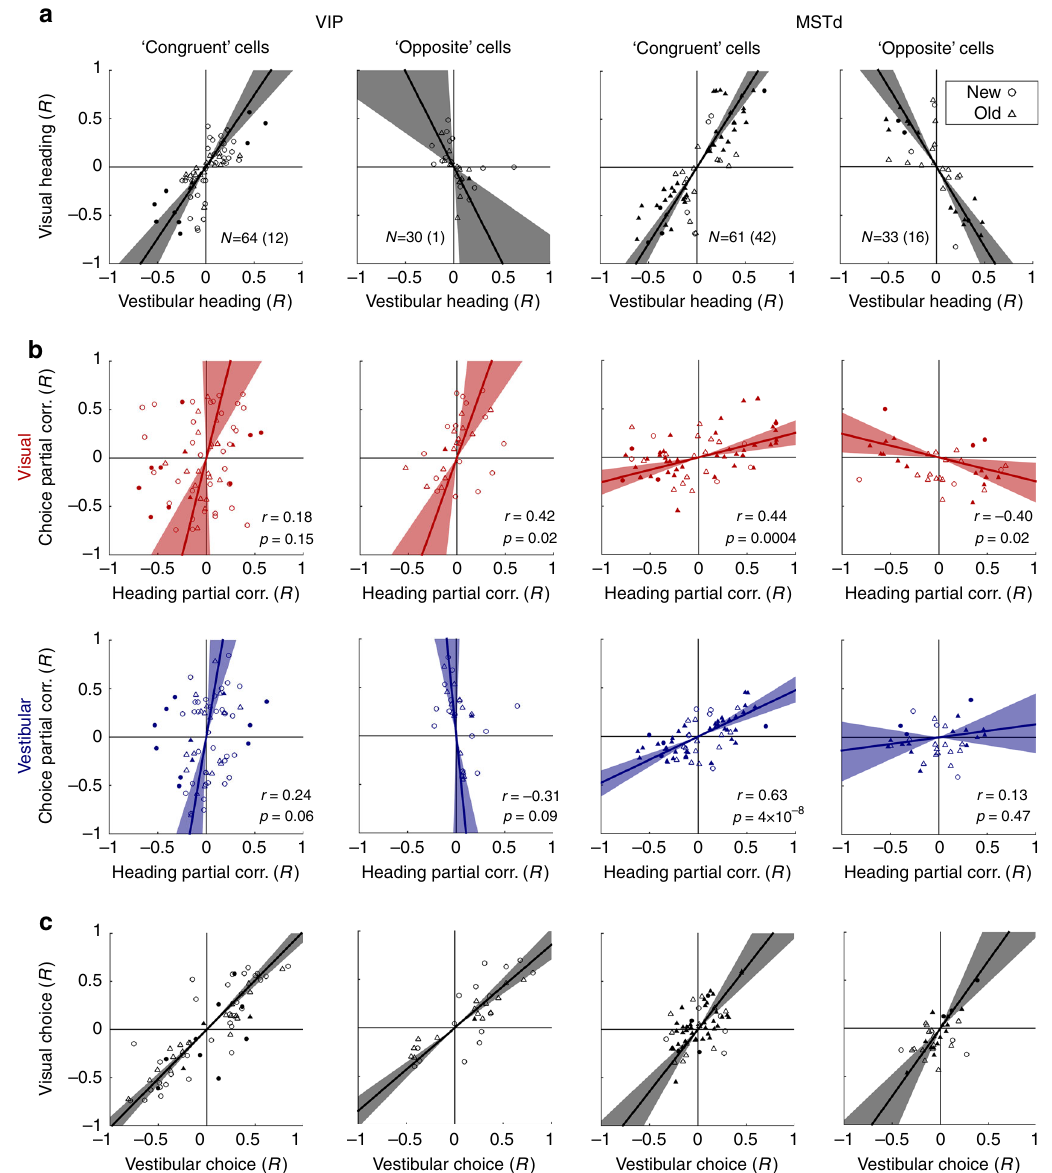
Fig. 5 Partial correlation results for congruent and opposite cells. a Visual and vestibular heading partial correlations are presented for neurons classi fi ed as ‘ congruent ’ or ‘ opposite ’ based on whether the visual and vestibular partial correlations for heading had the same or opposite signs, respectively. Signi fi cantly congruent or opposite cells ( p < 0.05 for both the visual and vestibular heading partial correlations) are marked by fi lled data points. Circle and triangle symbols mark the new and the old data sets, respectively. N values represent the number of cells (the number of signi fi cantly congruent or opposite cells in parentheses). Only cells which showed a signi fi cant main effect of heading or choice ( p < 0.05, two-way ANOVA) for both visual and vestibular conditions were included. b Heading and choice partial correlations are presented for the same cells. Red and blue symbols represent the data for the visual and vestibular conditions, respectively. c Choice partial correlations measured during the visual and vestibular conditions are compared for the same cells. Solid lines and the shaded regions represent type-II regressions with their 95% con fi dence intervals. r and p -values for the regressions in panel b are presented on the respective plots. For all the regressions in black ( a , c ) p < 0.001 (except for the second plot in a , for which p =